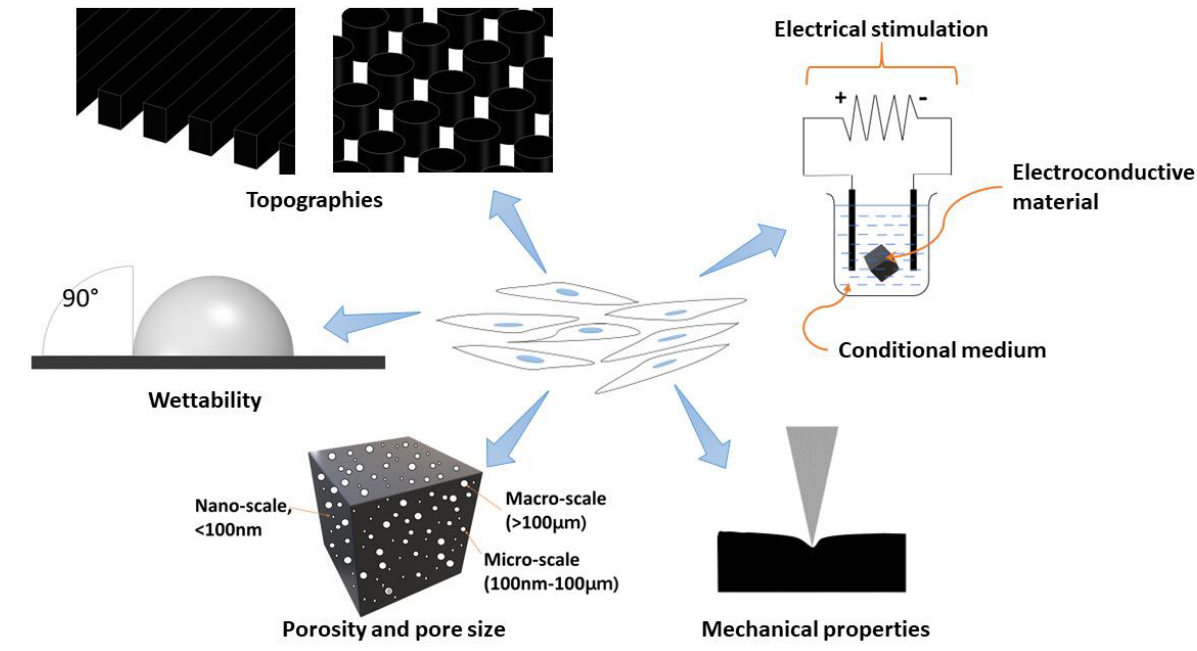
Figure 2. Schematic illustration of factors influencing the behaviours of stem cells.